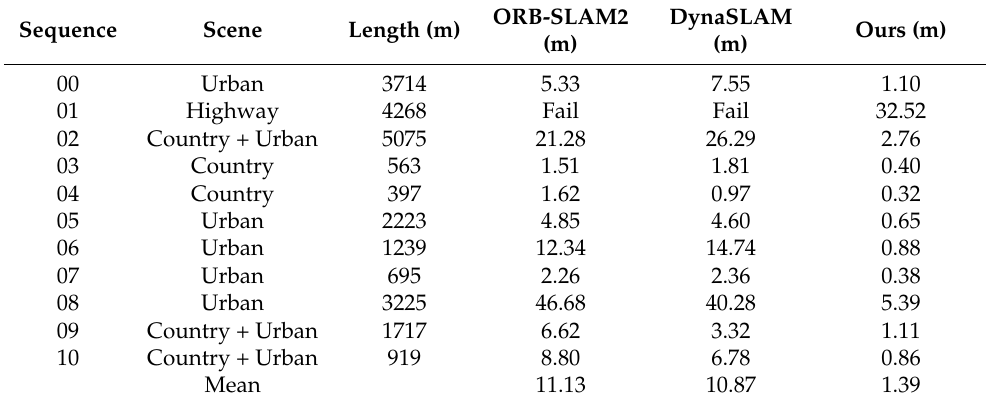
Table 2. Comparison of ATE (absolute trajectory error) on the KITTI Visual Odometry datasets.